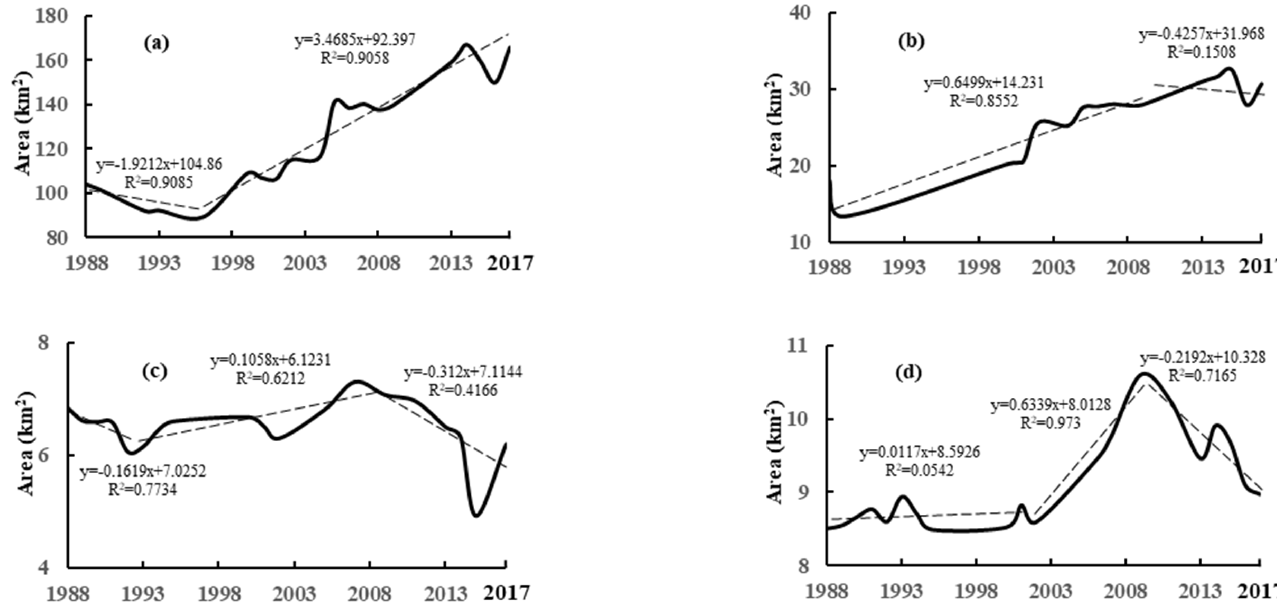
Figure 2. Changes of area in Lake Yagenco ( a ); Lake Zhamcomaqiong ( b ); Lake Zhamuco ( c ) and Lake Gaeencuonama ( d ) during 1988–2017.